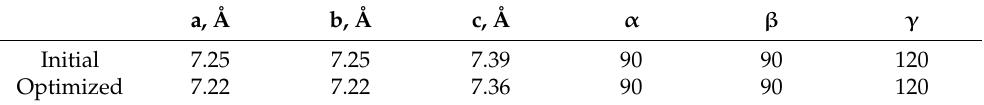
Table 1. Initial and optimized lattice parameters of the LaF 3